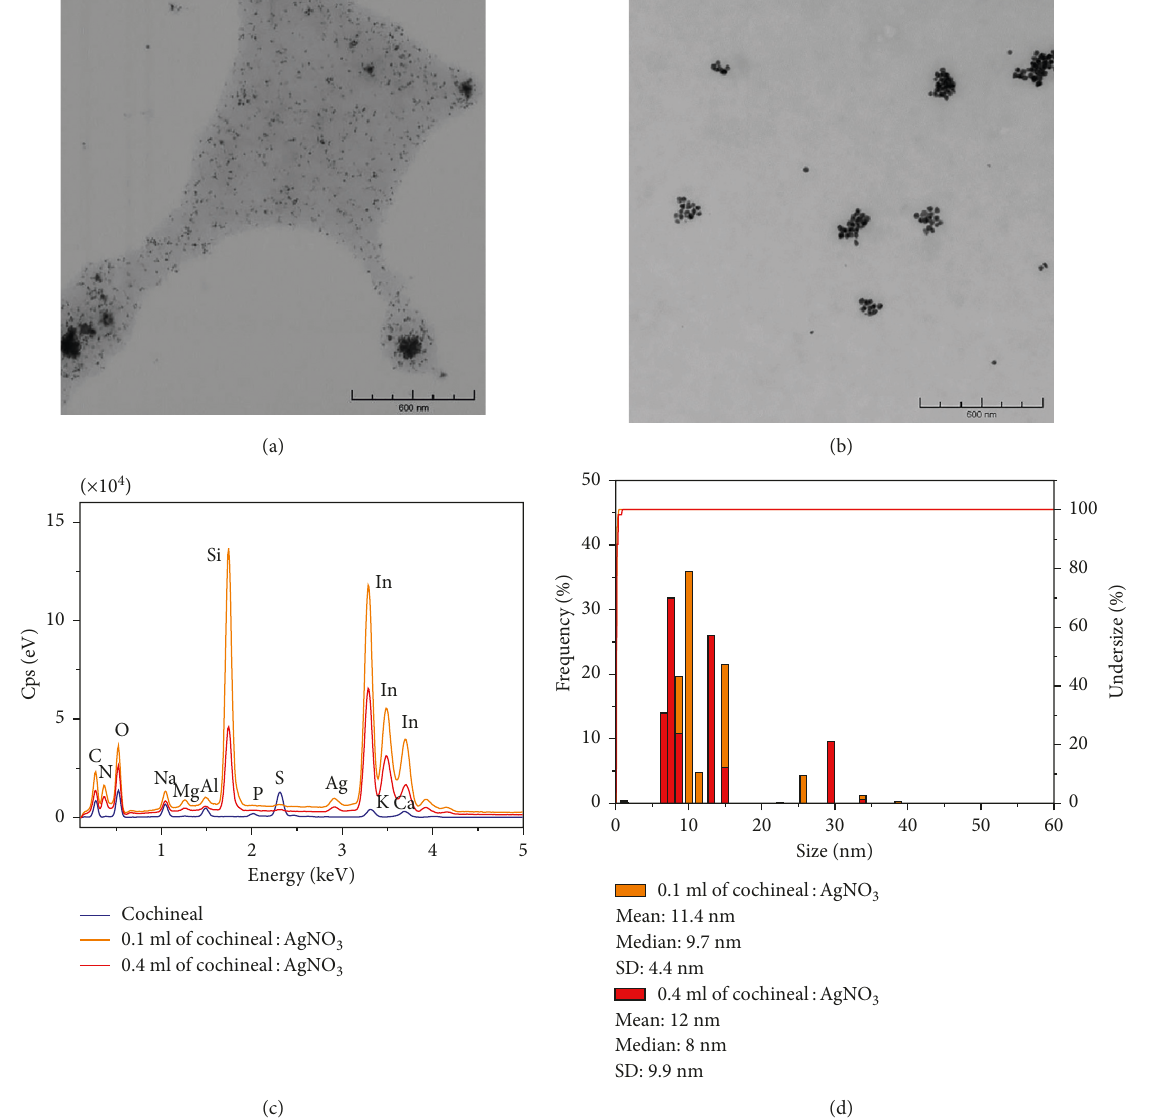
Figure 4: Scanning transmission electron micrographs of AgNPs synthesized from 0.1ml (a) and 0.4ml (b) of the cochineal extract and their (c) EDS spectra and (d) DLS